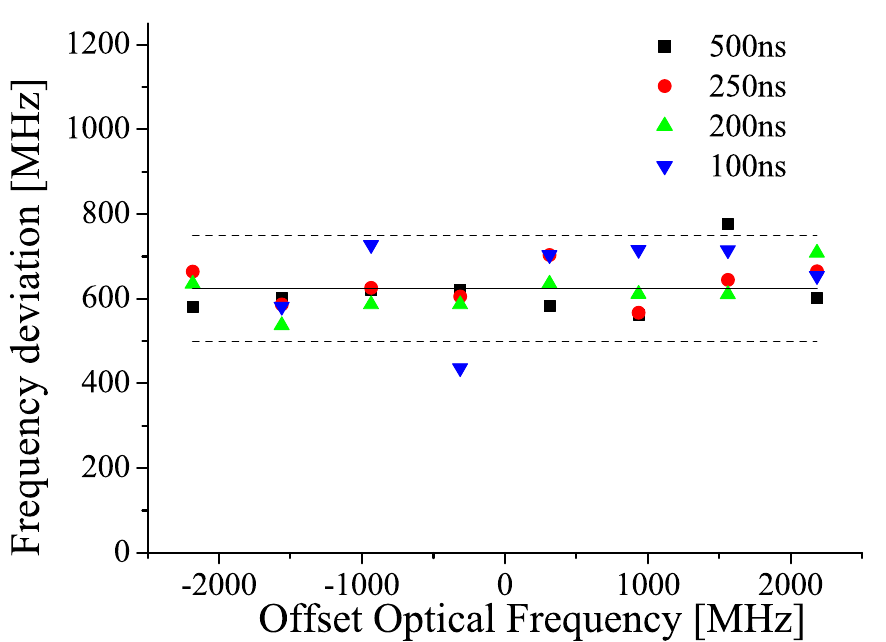
Figure 22. Peak position deviations with source laser sweep in 625 MHz step, where the frequency accuracy of the laser was 125 MHz.